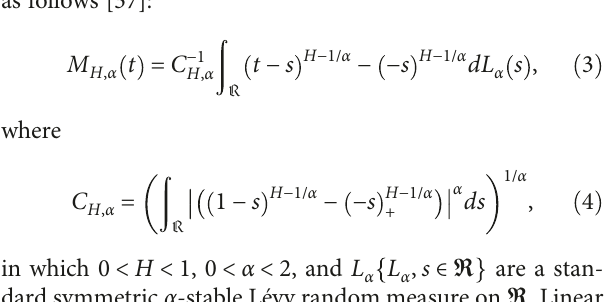
Figure 2: Comparison of the probability density distribution p of the maxima for two di ff erent data, where R = 365 , representing the annual interval. The blue line represents the long-range correlation data ( γ = 0 4 ), and the red line is shu ffl ed uncorrelated